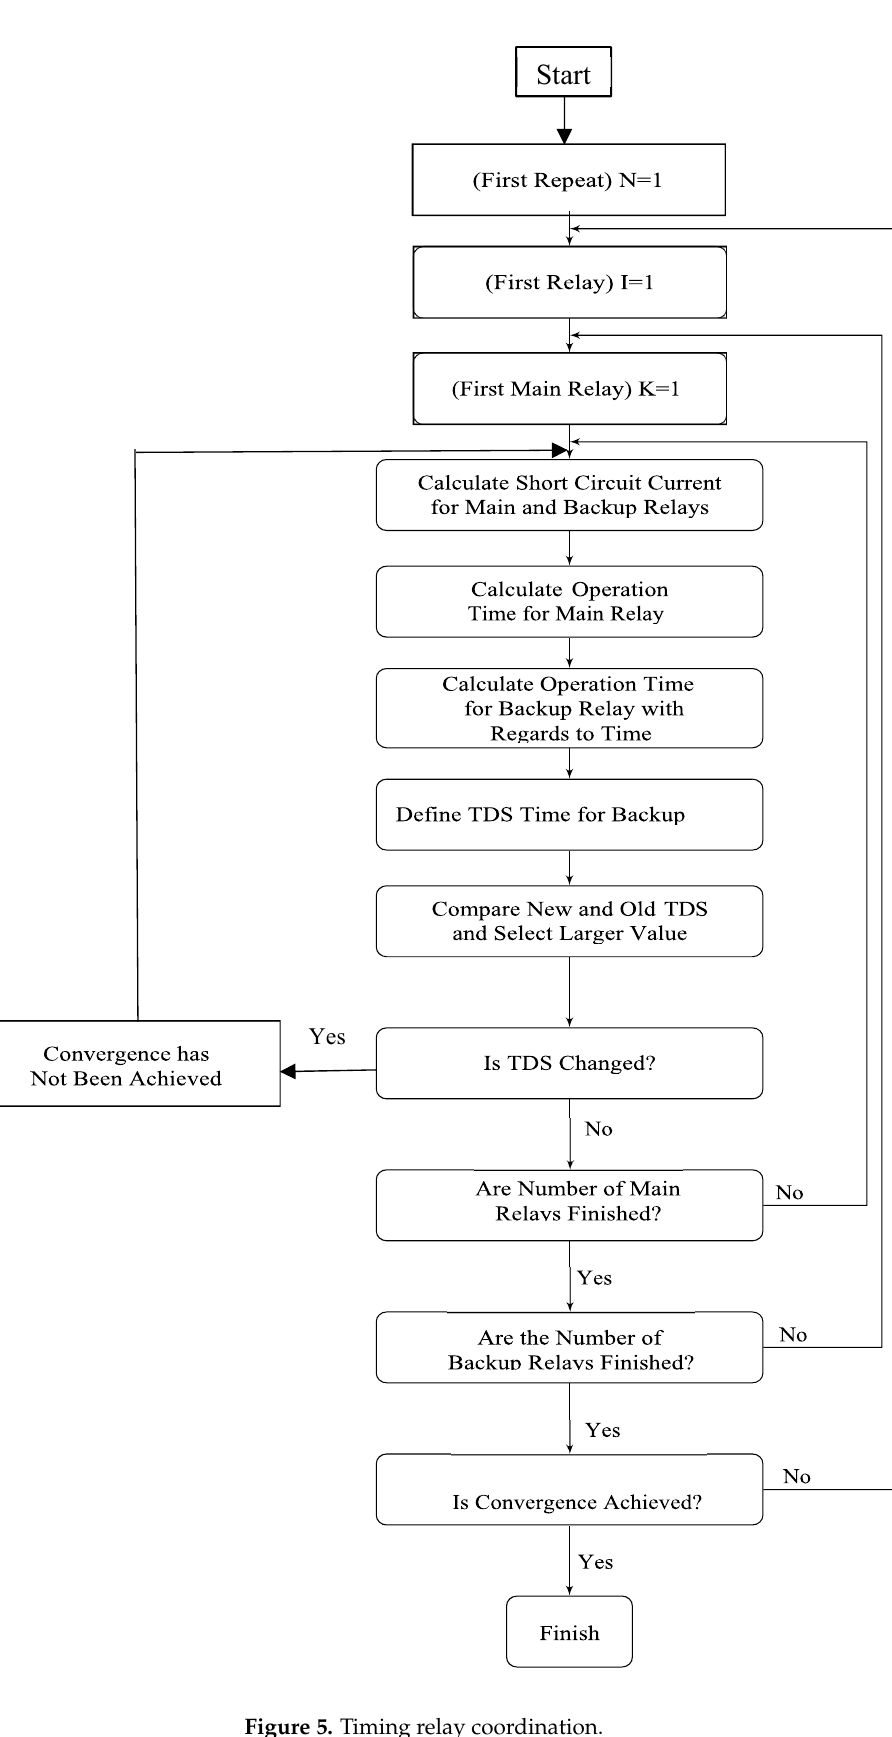
Figure 5. Timing relay